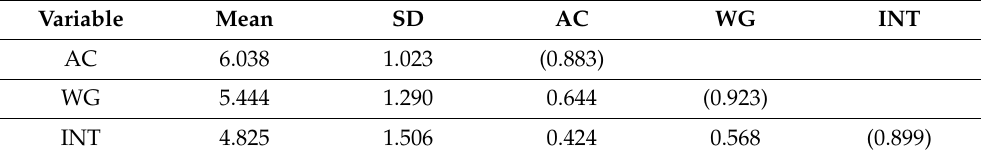
Table 2. Descriptive statistics in study 2.